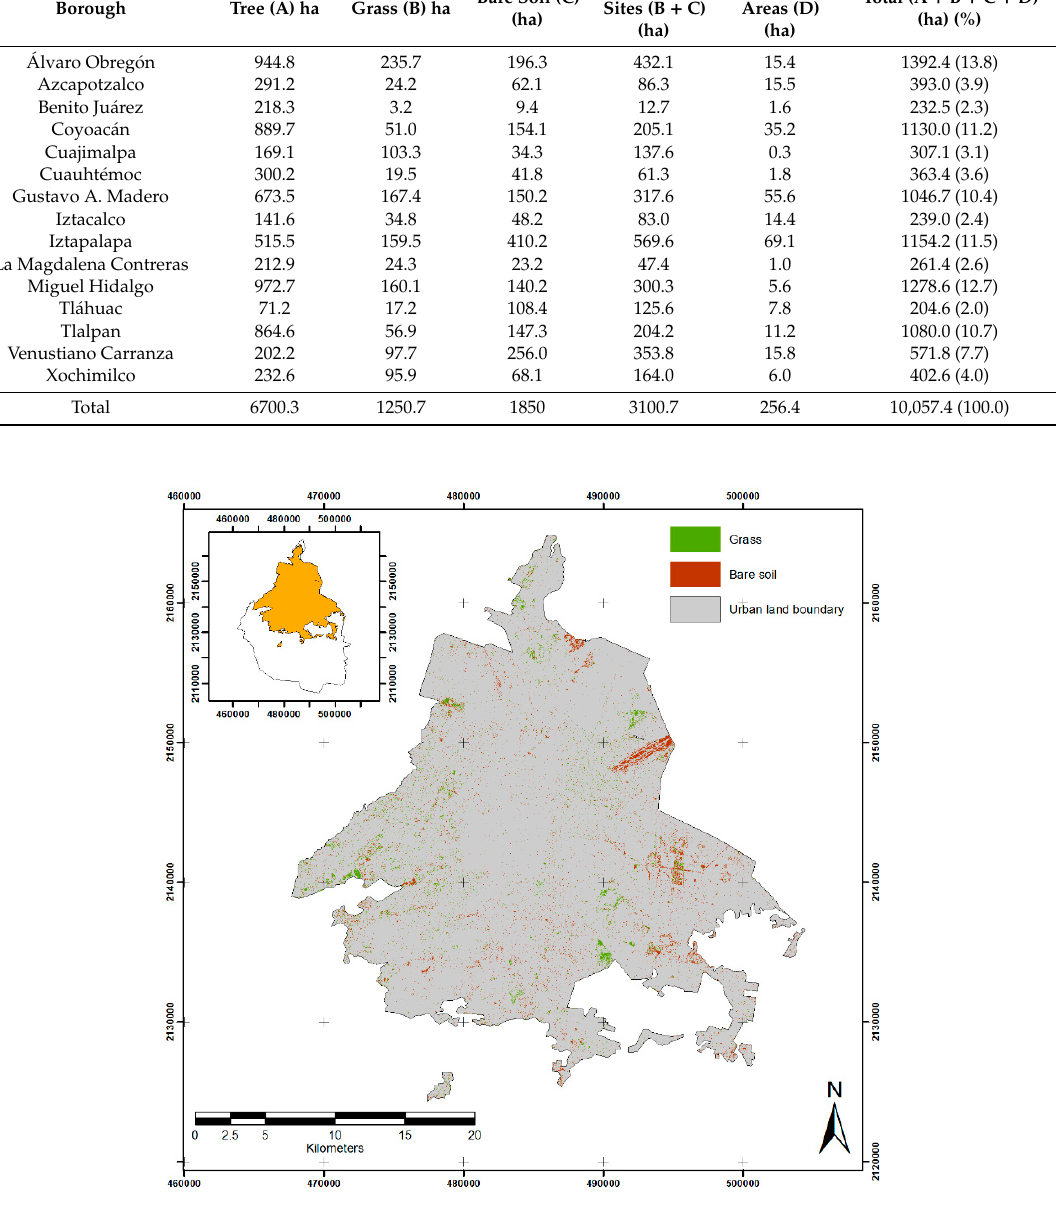
Figure 4. Potential planting sites (bare soil) in Mexico City’s urban land.